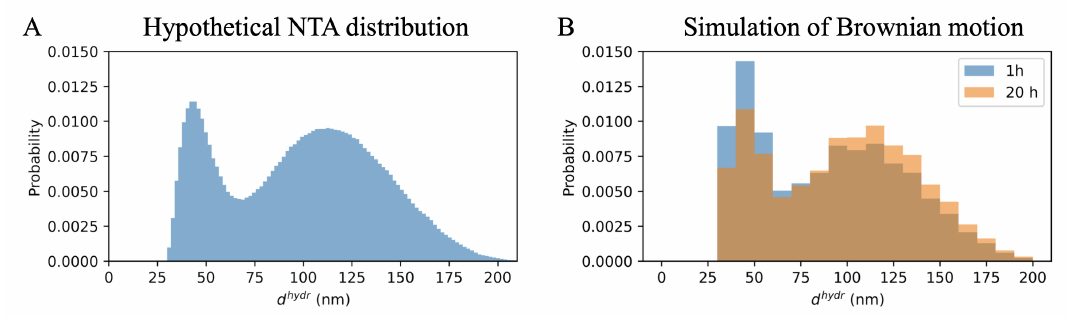
Figure 6. Results of the Monte Carlo simulation of settlement on the substrate of nanovesicles with hydrodynamic diameters drawn from the hypothetical bimodal distribution in ( A ). In ( B ), the blue histogram corresponds to 1 h, orange to 20 h from placing a 1 mm thick sample drop on the mica